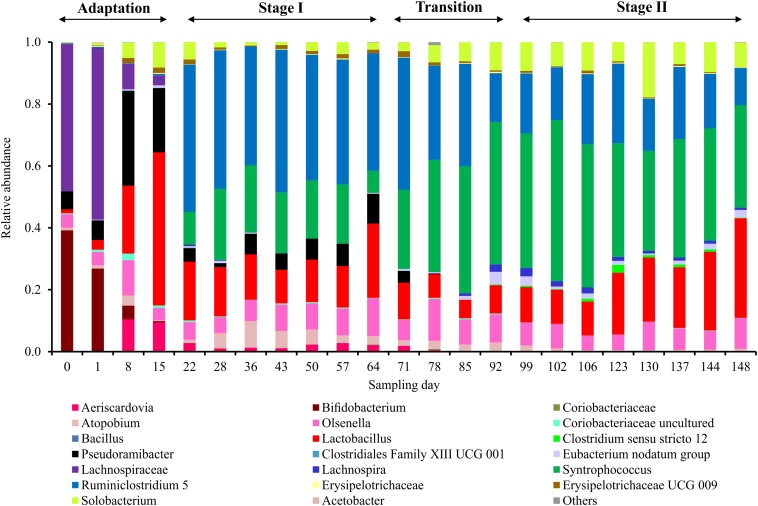
Microbial community composition profiles in the four succession stages based on amplicon sequencing of 16S rRNA genes. Taxonomic classification of amplicon sequence variants (ASVs) was categorized at the genus level. ASVs with relative abundance lower than 0.1% are classified into “Others.”